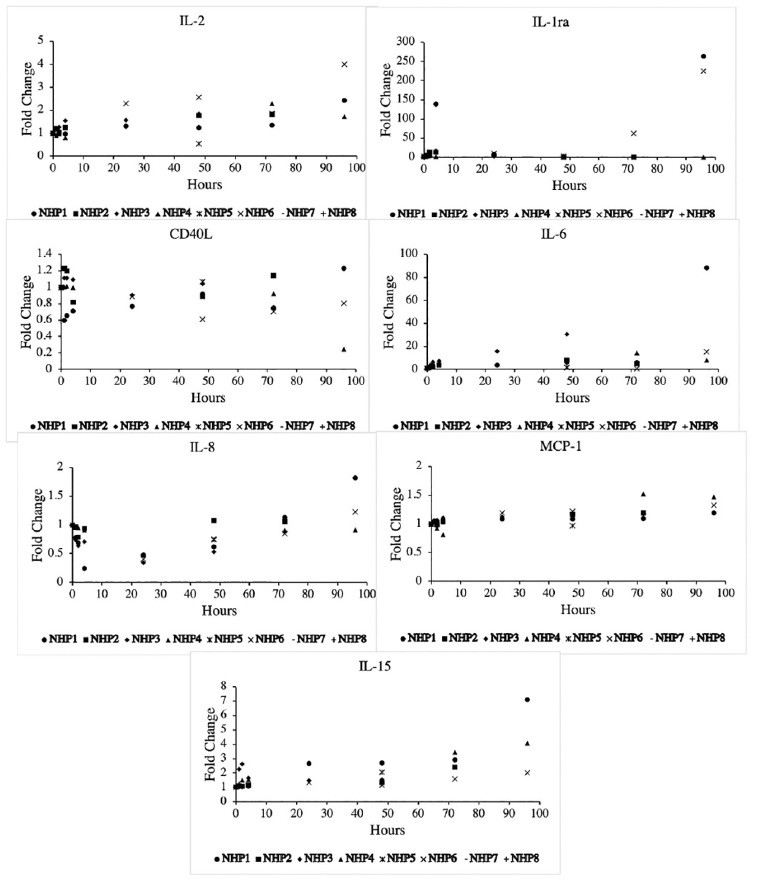
Fig 3. Selected biomarker results.